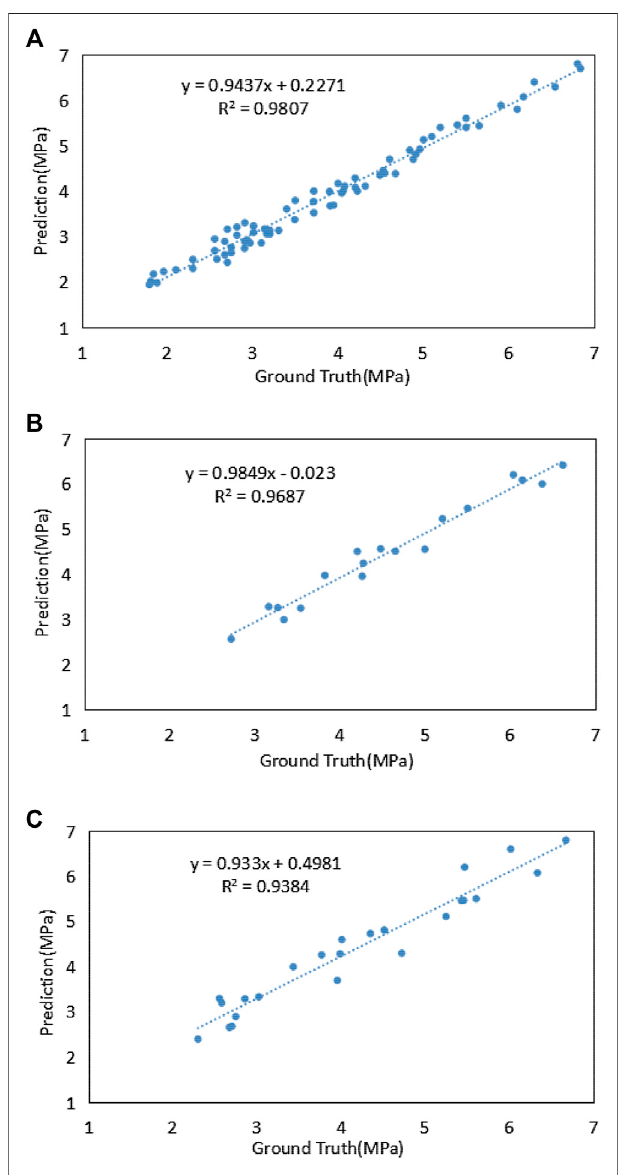
FIGURE 5 | Correlation between predicted and experimental fl exural strengths: (A) training dataset, (B) validation dataset, and (C) testing dataset of ELM.